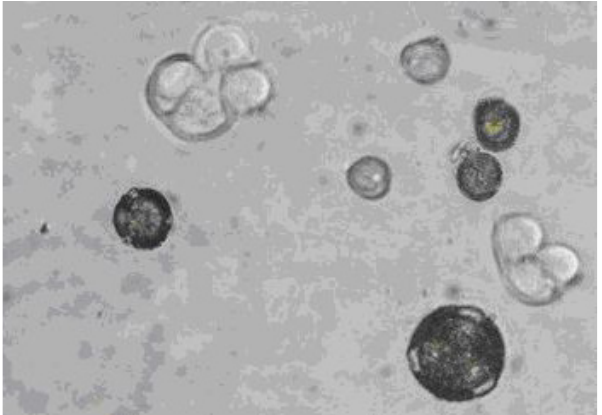
Fig. 4. Multicellular structures generated from Brassica